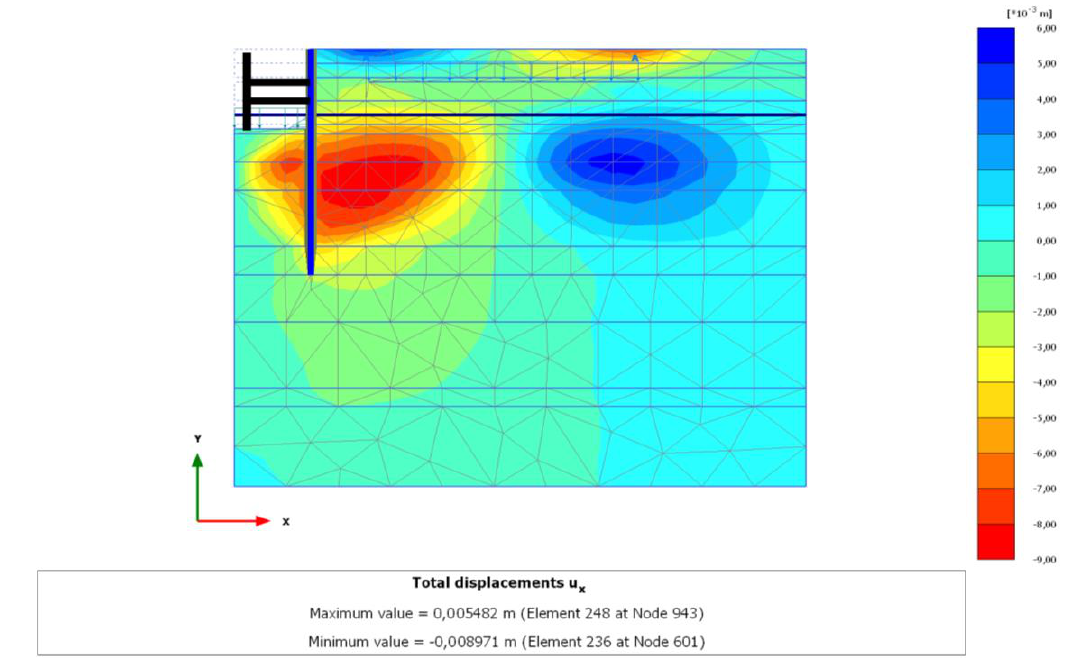
Figure 9. Total displacements along X axis